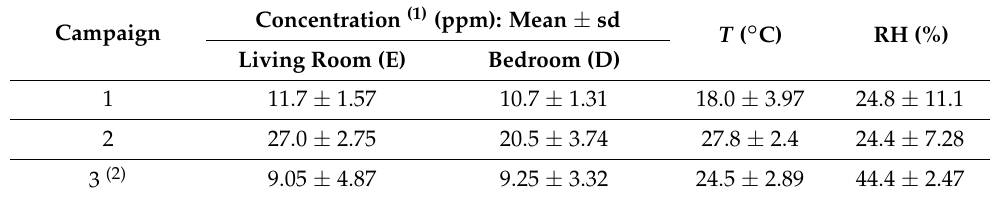
Table 1. Photoionization readings in the indoor air. Campaign